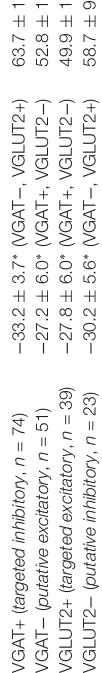
FIGURE 2 | Distinct action potential (AP) discharge patterns in excitatory and inhibitory populations. (A) Overlaid traces show representative examples of the characteristic patterns of AP discharge observed during increasing levels of current step injection (20 pA steps, 1 s duration). The red trace shows an exemplary response for each AP discharge pattern. Tonic firing (TF) responses included repetitive AP discharge throughout the depolarizing current step injection; initial bursting (IB) responses exhibited AP discharge that was restricted to the depolarization onset; Rapid Bursting responses were similar to IB, but spike onset coincided with a depolarizing hump that was clearly visible in the rheobase current response; Delayed firing (DF) responses exhibited AP discharge only after a delay from the depolarizing step onset; and Single Spiking responses only discharged a single AP at depolarization onset, regardless of depolarizing step amplitude. (B) Bar plots compare the incidence of each AP discharge patterns between cell